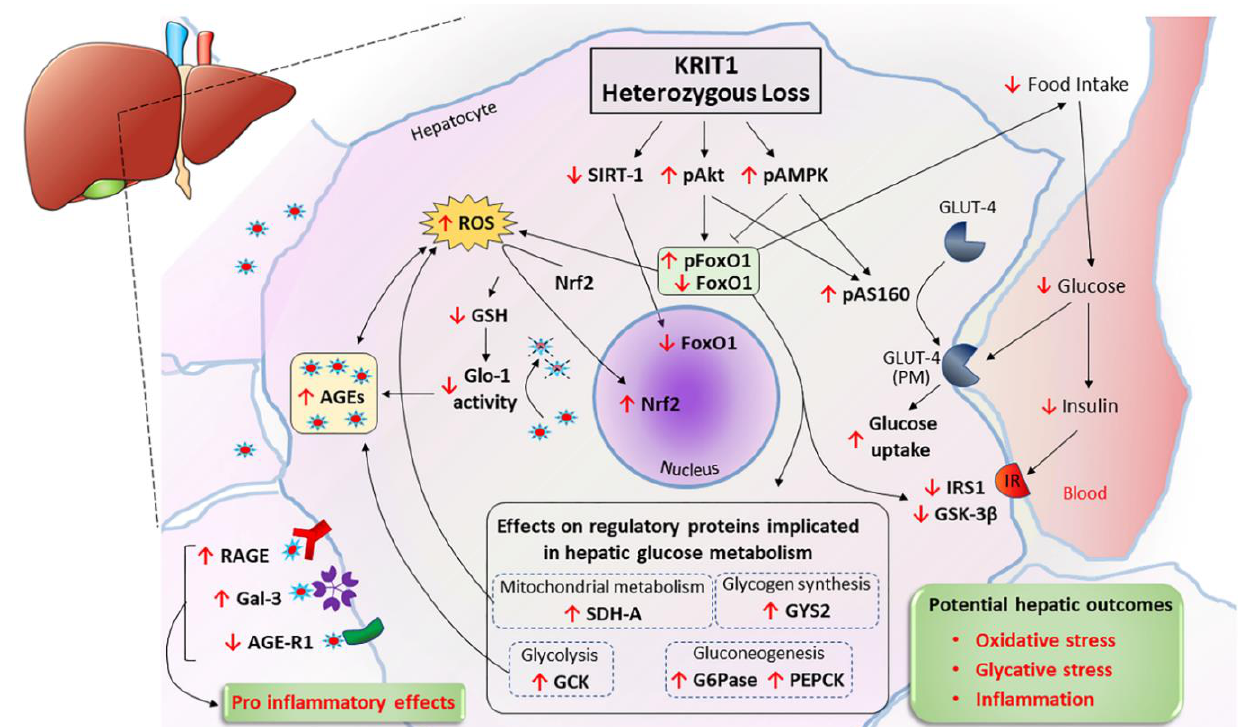
Figure 8. Schematic representation of the main effects of KRIT1 haploinsufficiency detected in the mouse liver. KRIT1 heterozygous loss results in the downregulation of FoxO1 expression/activity, which is likely attributable to substantial changes in three major regulators of FoxO1 nuclear/cytoplasmic shuttling and transcriptional activity, including enhanced activating phospho- rylation of Akt and AMPK serine/threonine kinases, and reduced expression of Sirt1 deacetylase. In turn, activated Akt and AMPK promote the activation of AS160, which is required for GLUT4 translocation of the plasma membrane and GLUT4-mediated glucose uptake, whereas FoxO1 down- regulation affects both ROS homeostasis and key markers of major hepatic metabolic processes, including gluconeogenesis (G6Pase, PEPCK), glycolysis (GCK), mitochondrial electron transport chain and energy metabolism (SDH-A), and glycogen synthesis (GYS2). As a likely consequence master antioxidant transcription factor Nrf2, a reduction of GSH levels and GSH-dependent activity